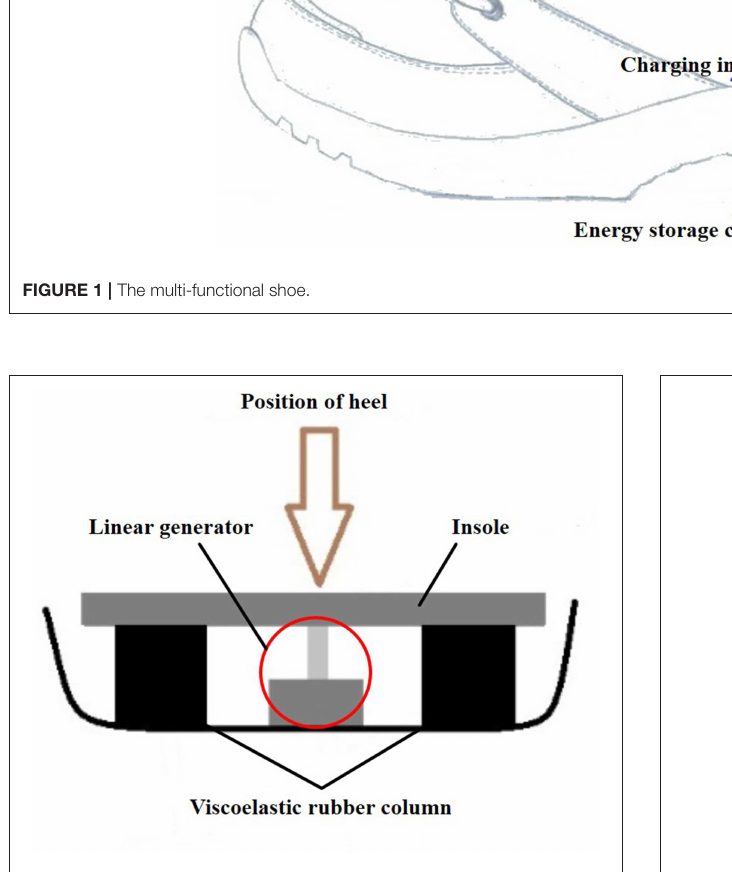
FIGURE 2 | Cross sectional view of the heel.